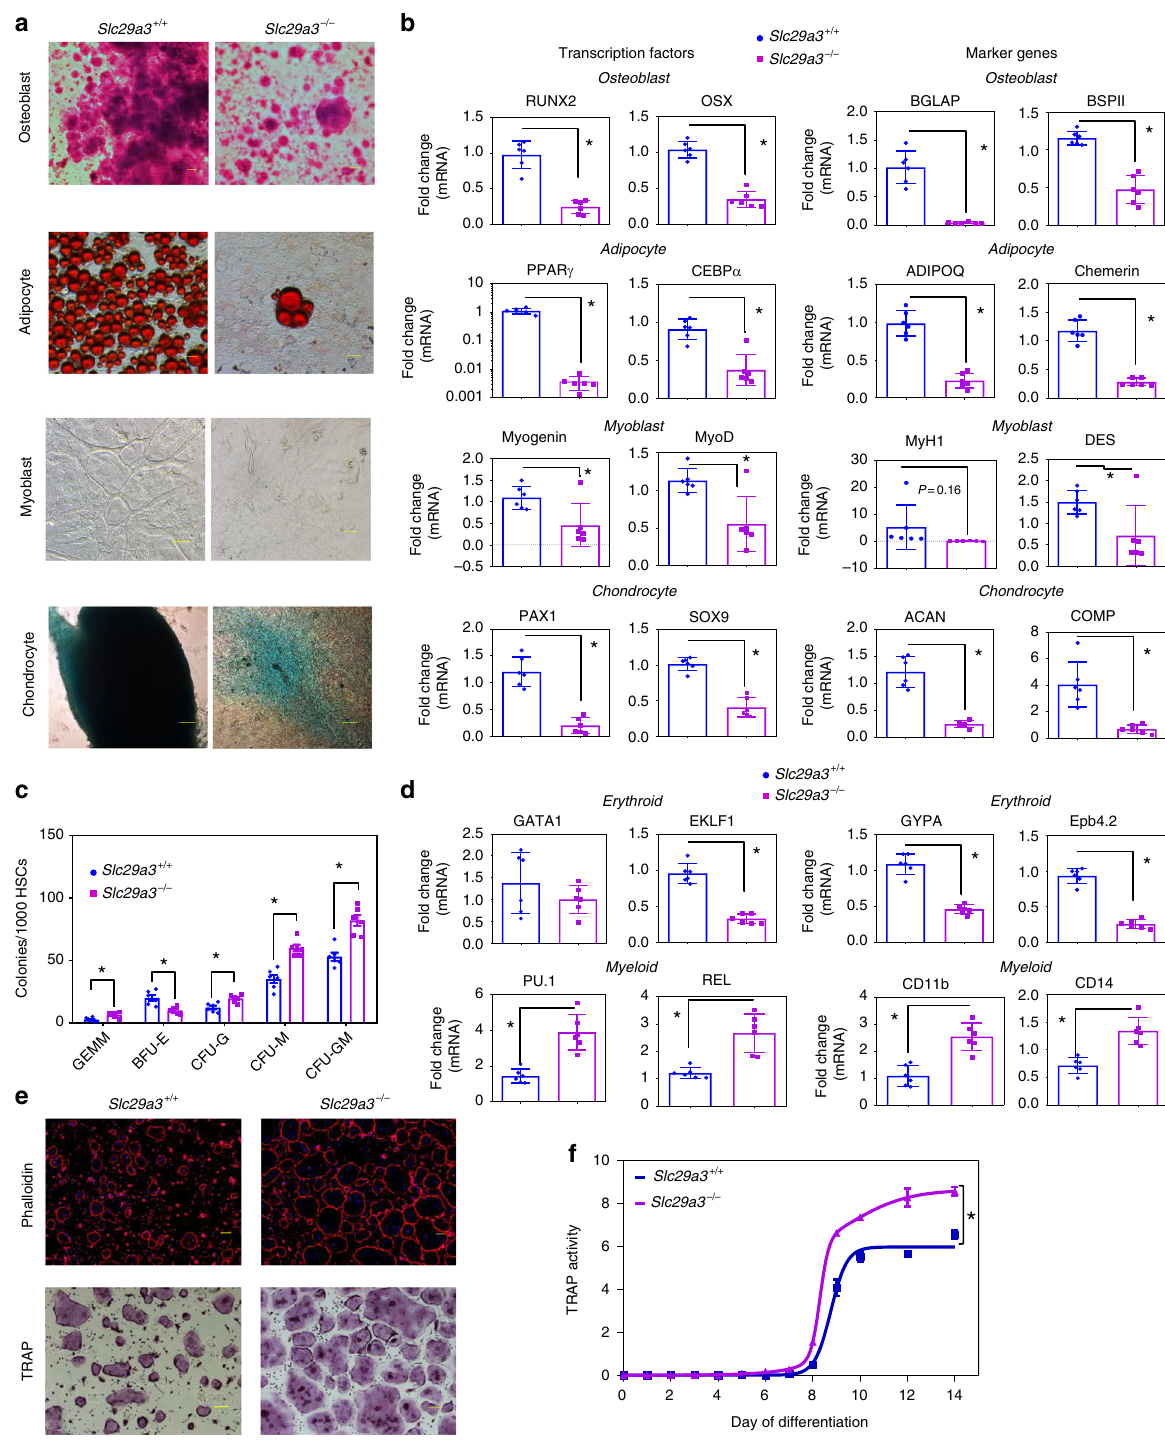
Fig. 2 ENT3 is essential for stem cell differentiation. MSC differentiation into osteoblasts (mineralized nodules; pink), adipocytes (lipid droplets; red), myoblasts (myotube formation), and chondrocytes (cartilage nodule; bluish green). Scale bar: 100 μ m ( a ). mRNA expression of transcription factors and markers after 14 (osteoblasts and adipocytes) and 28 (myoblasts and chondrocytes) days of MSC differentiation ( n = 6, mean ± SEM) ( b ). HSC colony- forming cell assay ( n = 6, mean ± SEM) ( c ) and transcript expression after 14 days of differentiation ( n = 6, mean ± SEM) ( d ). Osteoclast formation (actin ring; red, above) (Scale bar: 100 μ m) ( e ) and TRAP (tartrate-resistant acid phosphatase) expression (purple; below) (Scale bar: 100 μ m) ( e ) and secretion with HSC differentiation ( n = 6, mean ± SEM) ( f ). GEMM, granulocyte, erythrocyte, monocyte, megakaryocyte; BFU-E, burst-forming unit-erythroid; CFU, colony-forming unit; CFU-M, CFU-macrophage; CFU-G, CFU-granulocyte; CFU-GM, CFU-granulocyte/macrophage. Statistical analyses were performed using ANOVA with Tukey ’ s multiple comparisons post-test and two-tailed Student ’ s t- test. * P < 0.05. Source data are provided as a Source Data fi le